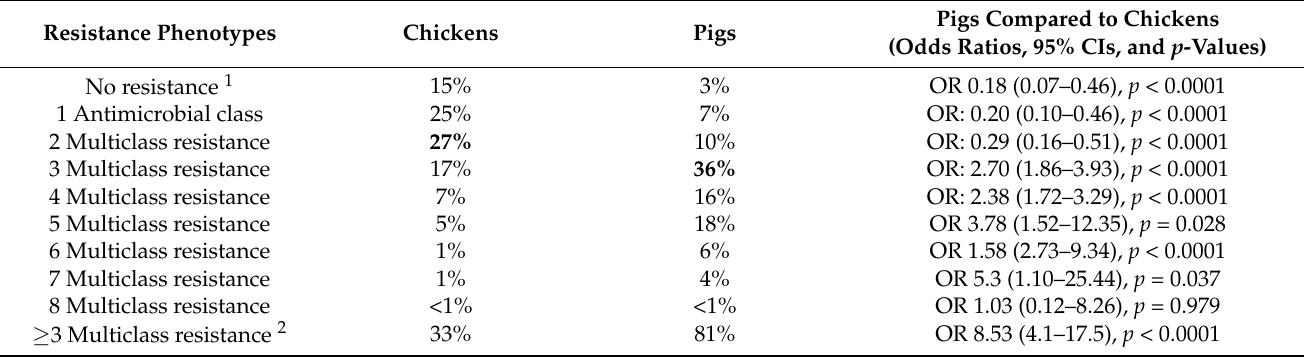
Figure 7. Distribution of the resistance phenotypes (number of individual antimicrobials in the pattern) in Salmonella spp. from chickens (depicted by the yellow bars; n = 698) and in pigs (depicted by the brown bars; n = 675) ( A ), and the distribution of resistant phenotypes (number of classes in the pattern) in chickens ( B ) and pigs ( C ). Please refer to the Supplementary Materials, Table S3A,B, for the specific antimicrobial resistance phenotypes. Table 3. Antimicrobial resistance phenotypes in Salmonella spp. from chickens ( n = 698) and pigs ( n = 675) in the Lao PDR, 2018–2021, and comparison of the differences in percentages between pigs (referent species) and